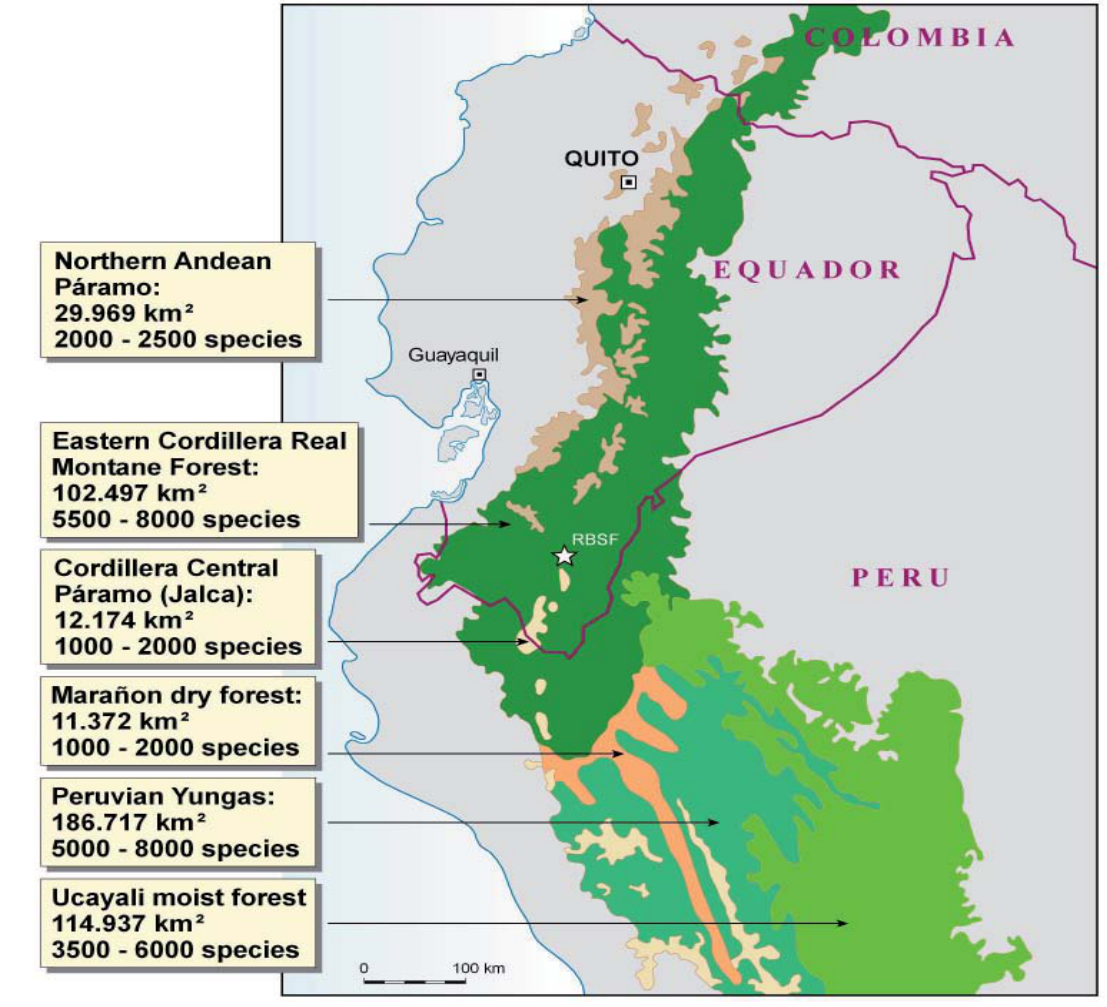
Figure 8: Ecoregions and their vascular plant species numbers in the transition zone between the northern and central Andes. Source: Morrison et al. (2001), from Beck & Richter